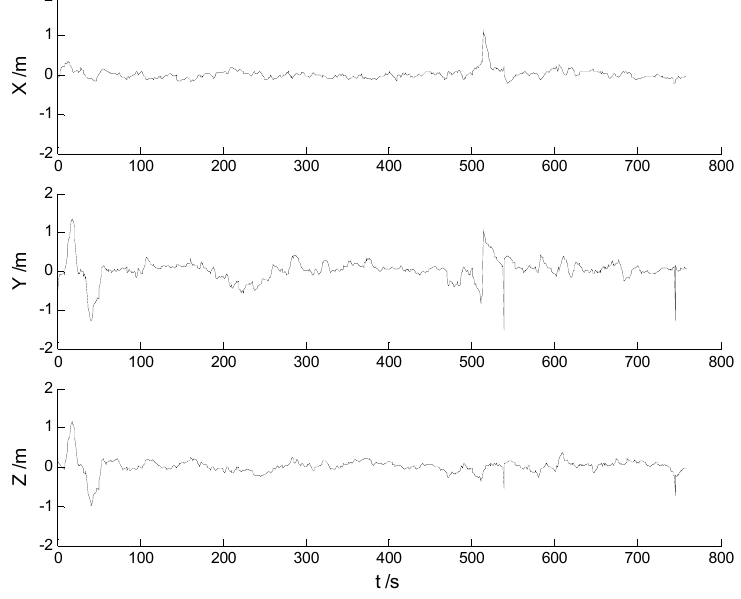
Figure 2. Position errors of the CKF algorithm.